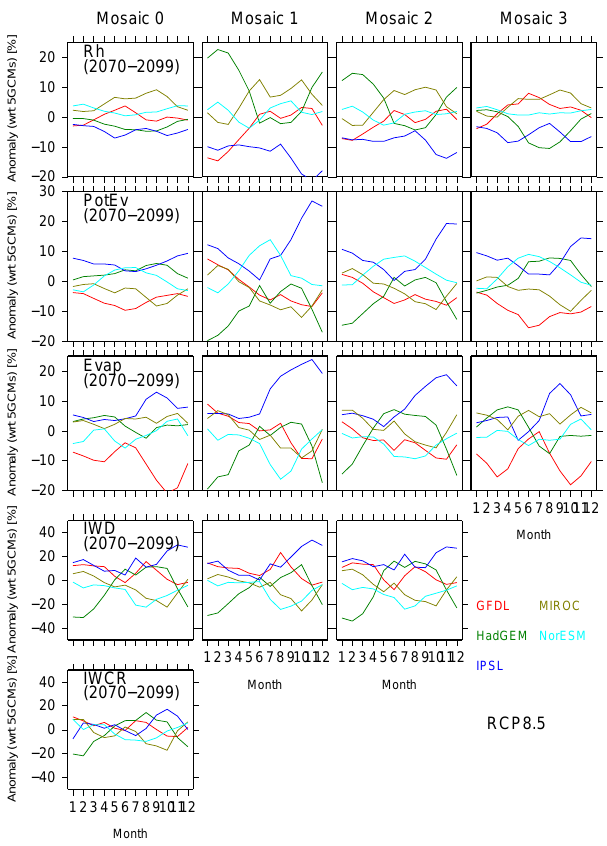
Figure 9. Same as in Fig. 8 but for the future period (2070–2099) under